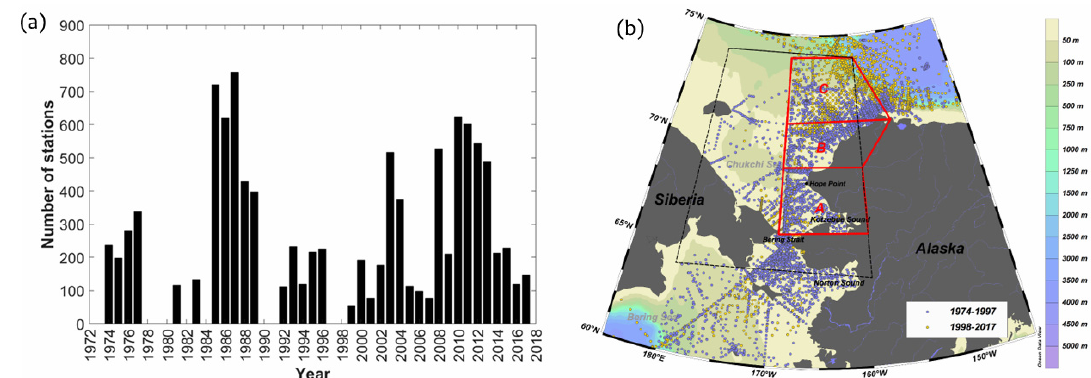
Figure 1. ( a ) Temporal distribution of the number of observation stations per year from 1974 to 2017 based on WOD13 and CNARE. ( b ) Distributions of all available T and S profiles in the study region; purple dots represent observations during 1974–1997, and yellow dots represent observations during 1998–2017; black dashed box represents the area for the T–S diagram; red boxes marked by A (66 ◦ –69 ◦ N, 170 ◦ –160 ◦ W), B (69 ◦ –71 ◦ N, 170 ◦ –165 ◦ W) and C (71 ◦ –74 ◦ N, 170 ◦ –160 ◦ W) represent the three study subregions in Section 3.3.3.